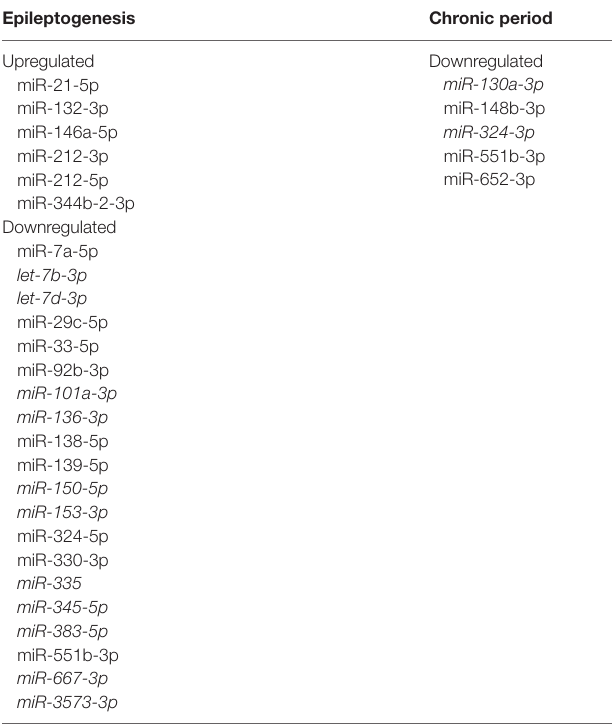
TABLe 1 | Differentially expressed microRNAs in the epileptogenesis and in the chronic period, as compared with controls. epileptogenesis Chronic